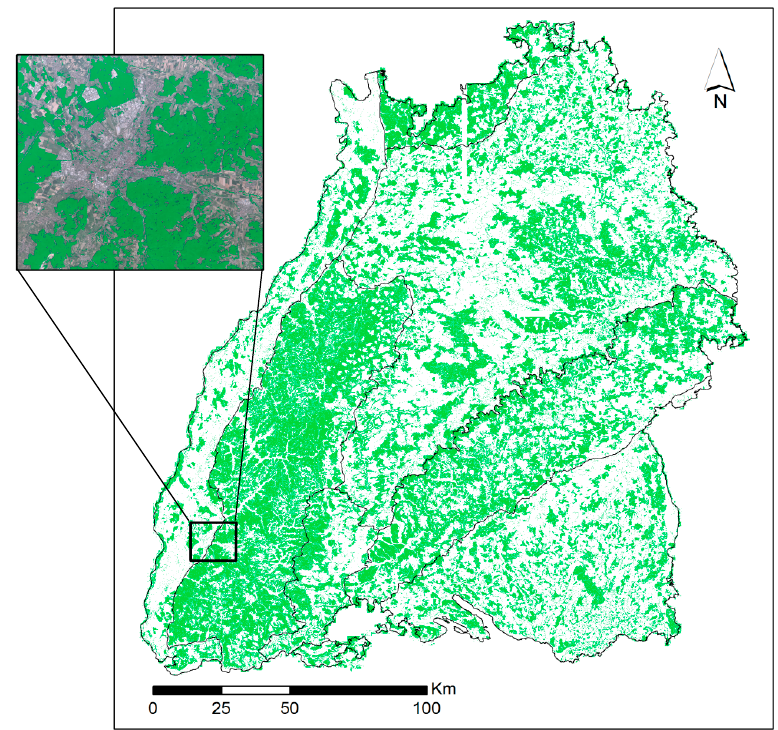
Figure 6. Forest cover map of Baden-Württemberg. The detailed map illustrates the forest cover in and around the city of Freiburg. Table 2. Confusion matrix of NFI plot data and forest cover map (fcm). OA = overall accuracy, UA = user’s accuracy, PA = producer’s accuracy, κ = Kappa value.